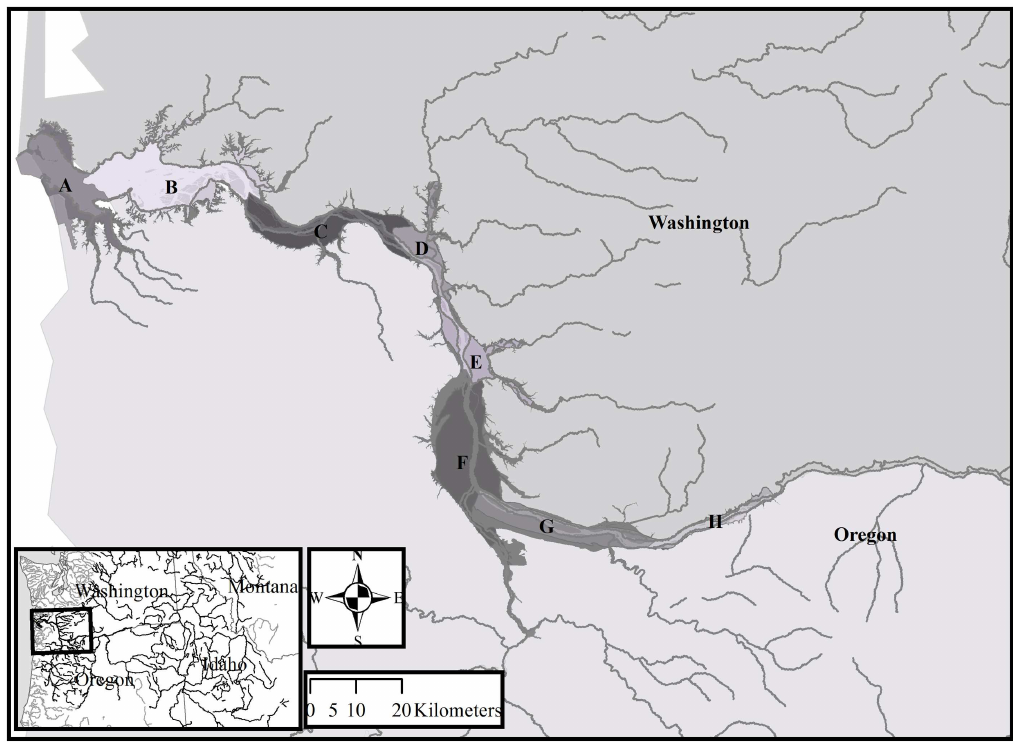
Fig 1. ColumbiaRiver basin(inset),and Level 3-HydrogeomorphicReaches(A-H)from the ColumbiaRiver Estuary EcosystemClassification(adaptedfrom Simenstadet al. [13]).